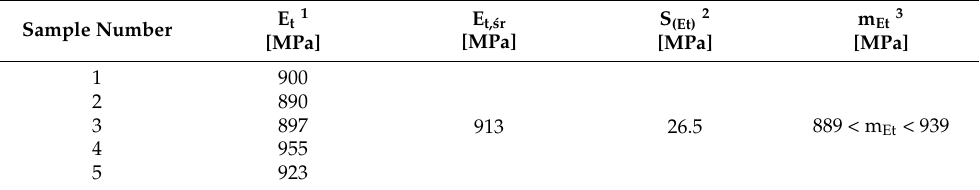
Figure 21. Graph of stress σ f to strain ε f (marked: points for determining the elasticity module at flexural, stress at conventional bend and maximum stress at deformation ε f = 5%). Table 3. Results of determination of the elasticity modulus under tension E t for a population of 5 samples.